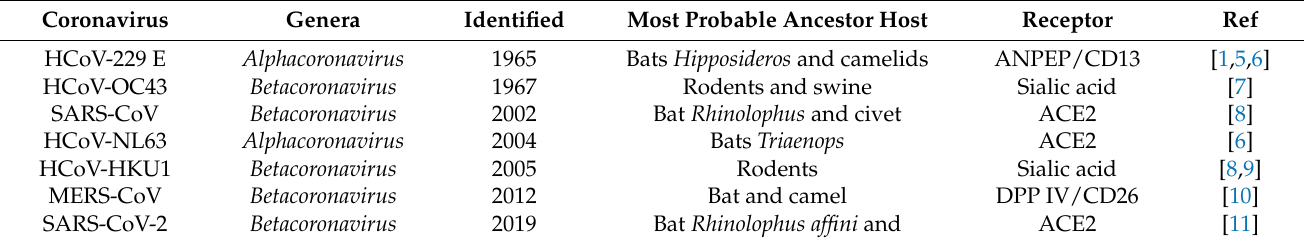
Table 1. Human coronaviruses and their most probable ancestor host. Seven human coronaviruses have emerged from zoonotic transmission